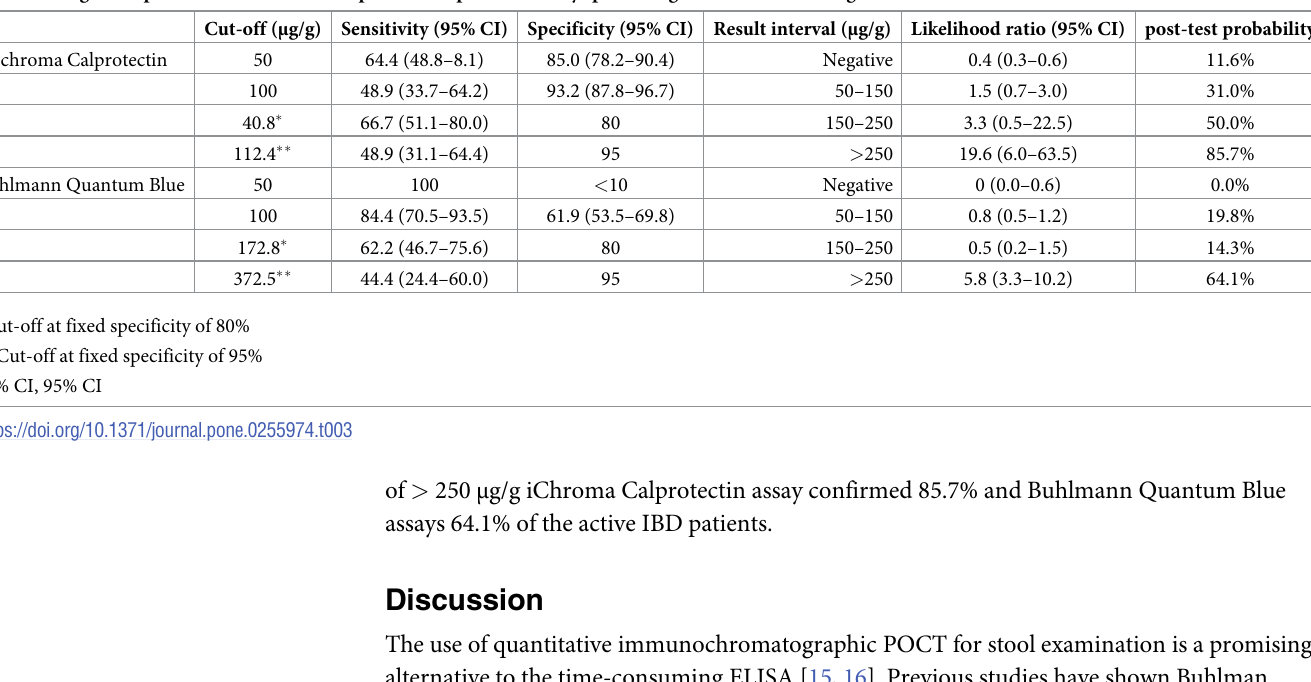
Table 3. Diagnostic performance of the two rapid fecal calprotectin assays predicting active IBD according to the various cut-off values and result